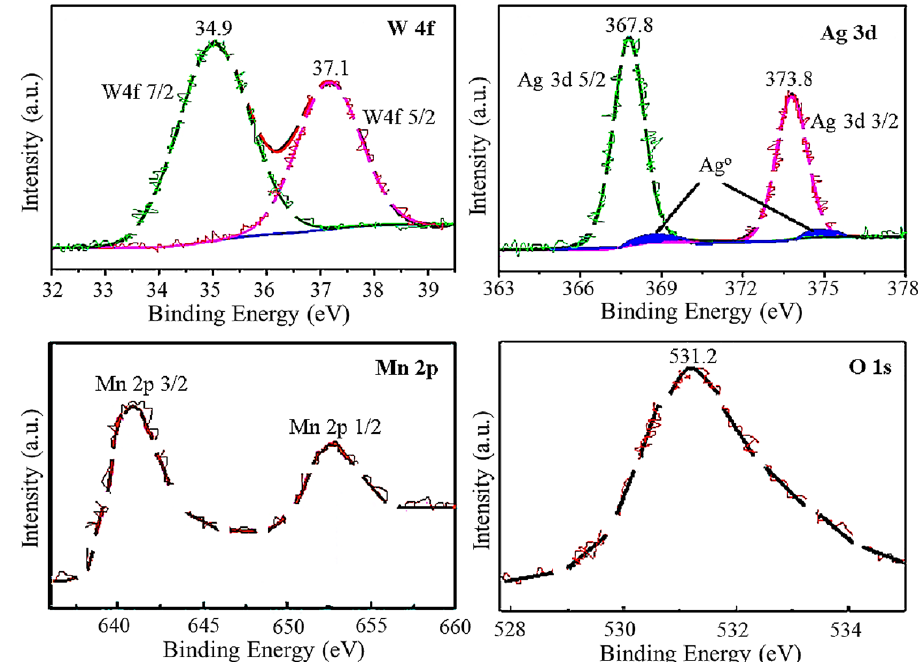
Figure 3. X-ray photoelectron spectra of W 4f., Ag 3d, Mn 2p, and O 1 s of 15 wt% Mn 3 O 4 / Ag 2 WO 4 (60)